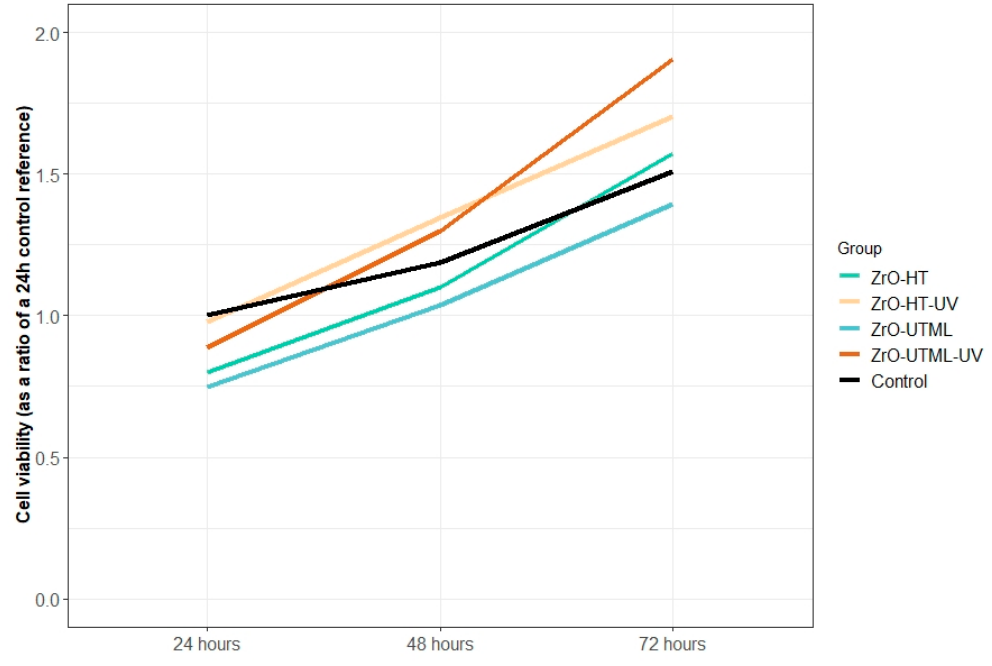
Figure 6. The tendency of HGF proliferation in the different study groups for the tested time- at 24, 48, and 72 points at 24, 48, and 72 h.